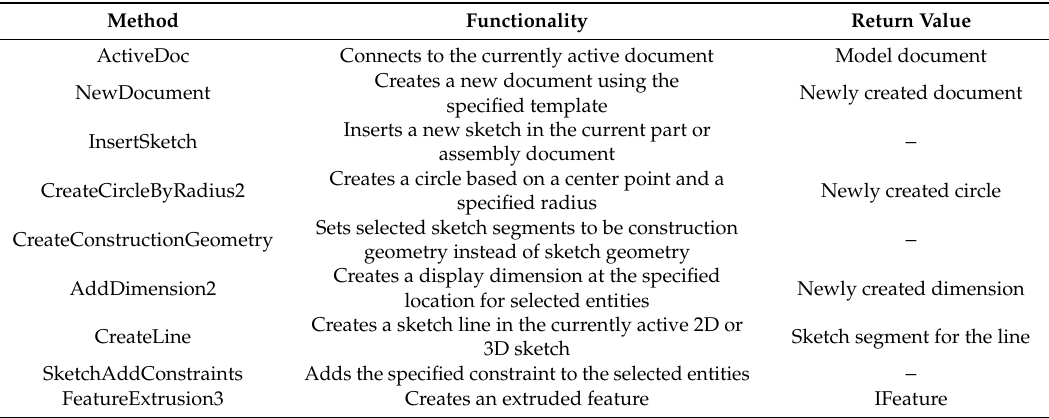
Table 1. API methods used for the contour